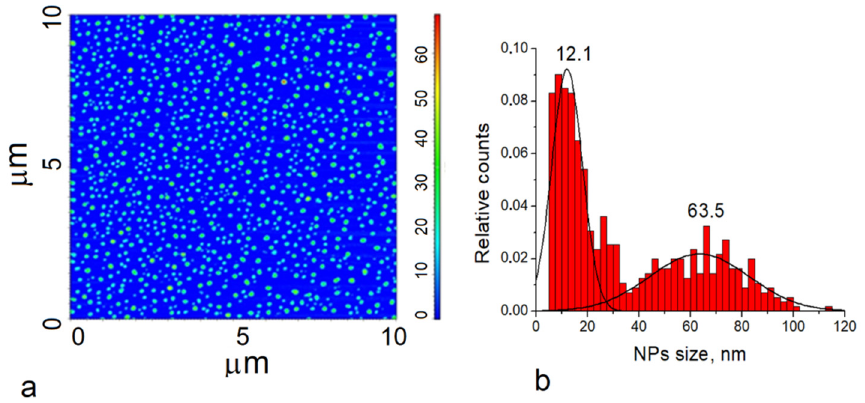
Figure 5. Atomic force microscopy-based analysis of TiO 2 -NPs (rutile) solution: ( a ) phase image of TiO 2 -155 NPs; ( b ) size distribution of TiO 2 -NPs